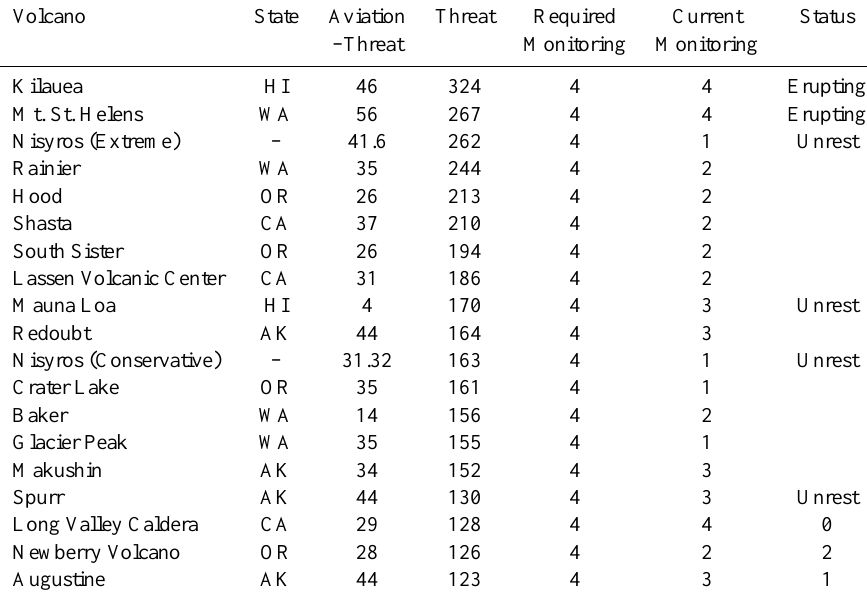
Table 2. Threat score for Nisyros in relation to 18volcanoes that make up the “Very High Threat” group in the United States. Following Ewert (2007) the volcanoes that are currently displaying unrest or that are already erupting are shown in the “Status” section. The scores for Nisyros are displayed for comparison. Volcano